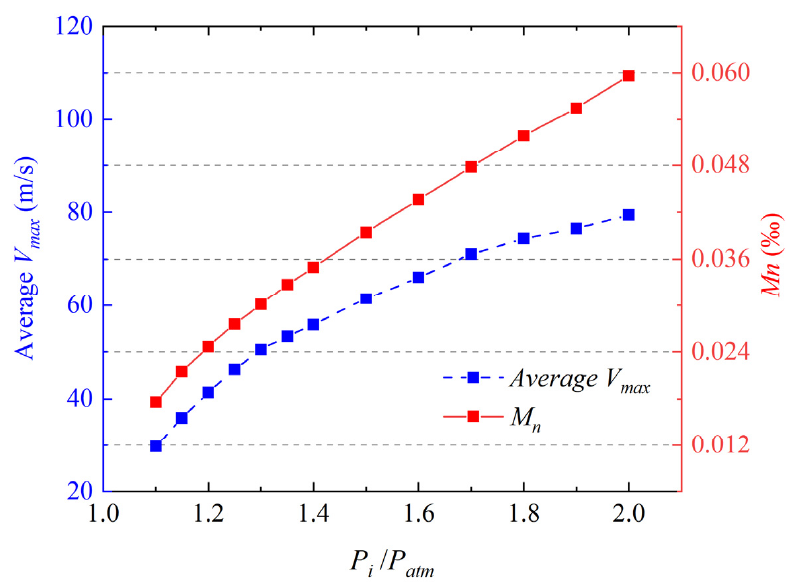
Figure 11. The oscillator’s average 𝑉 (cid:3040)(cid:3028)(cid:3051) and mass flow rate response.